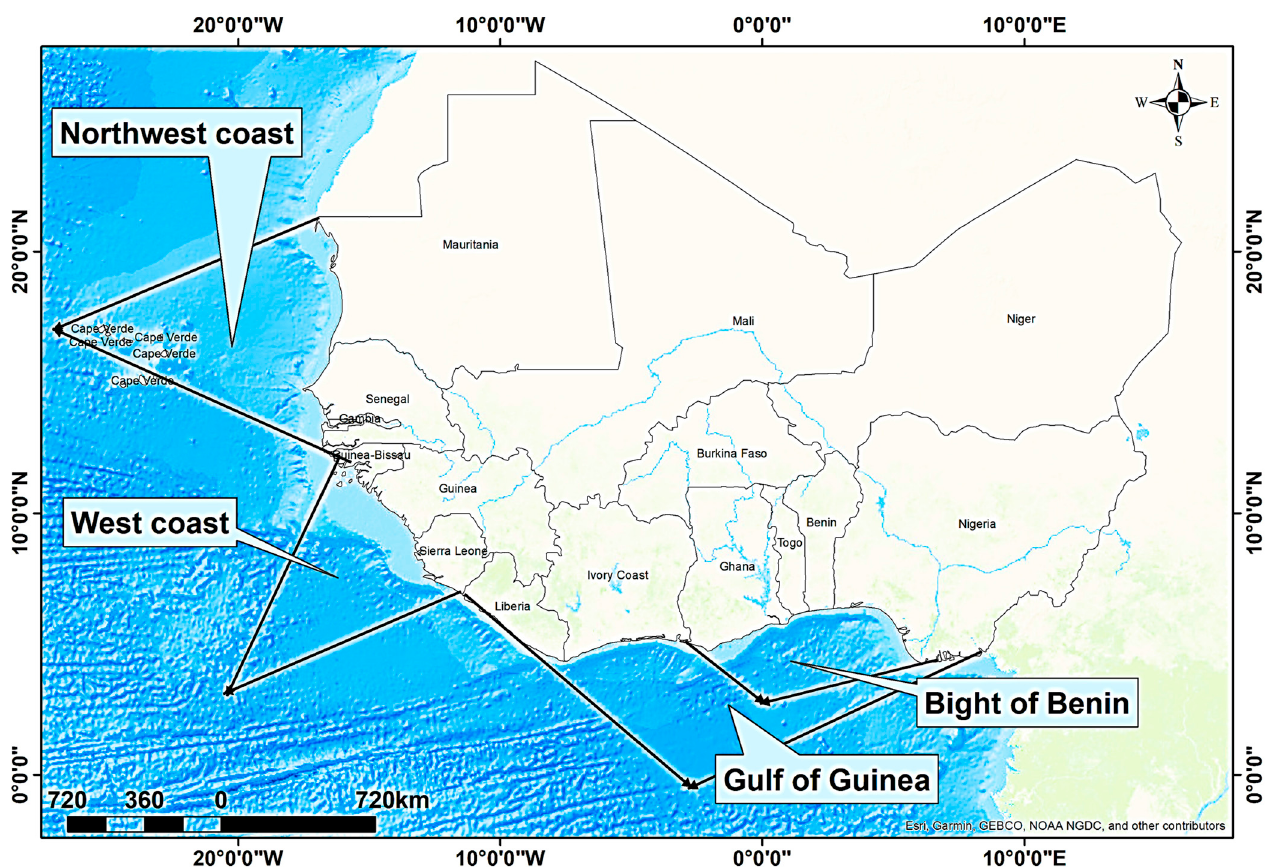
Figure 1. Map showing the division of the West African coast based on geomorphology.